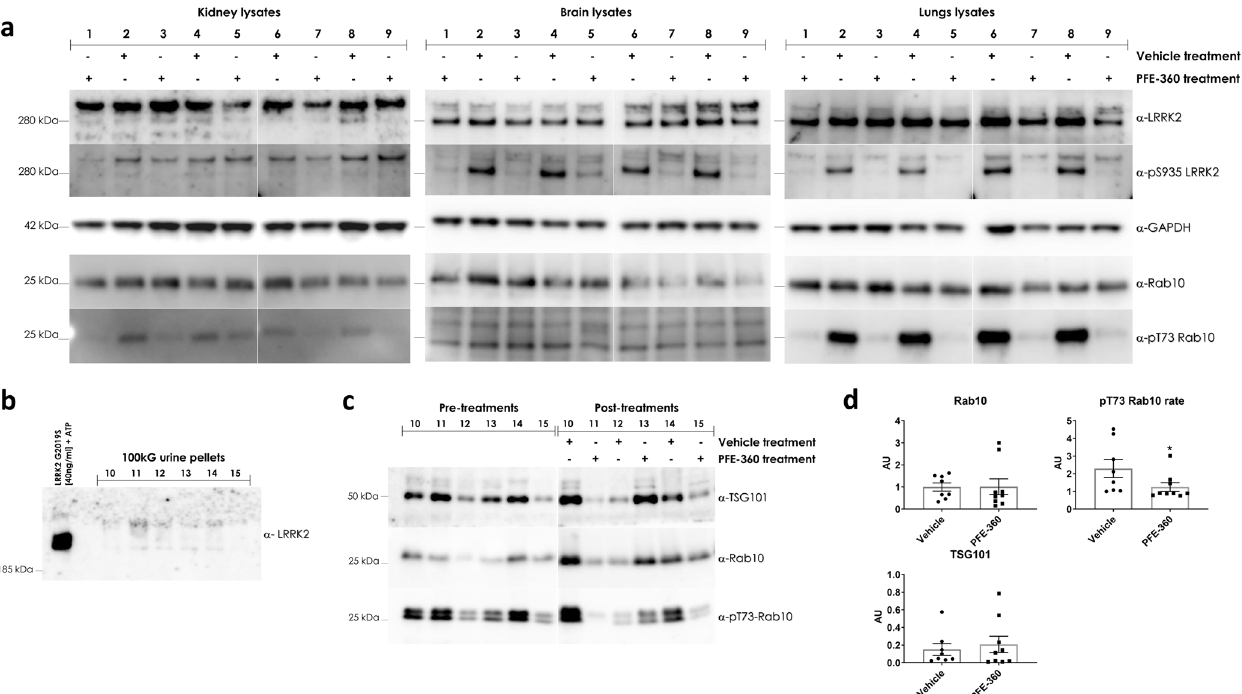
Fig. 5 Detection of LRRK2 & Rab10 in rat organ lysates and in urinary EVs after solvent and LRRK2 kinase inhibitor treatment. a Western blot detection of total LRRK2, pS935-LRRK2, total Rab10, pT73-Rab10 and TSG101 in kidney, brain and lung lysates of rats treated with PF360 or solvent (7.5 mg/kg, 6 h). Note that the blots in kidney yield a non-speci fi c band at a higher molecular weight. b Detection of total LRRK2 in normal rat uEVs, showing very low LRRK2 levels. c Western blot detection of total total Rab10, pT73-Rab10 and TSG101 in rat uEVs, both pre- treatment and after administration of PF360 or solvent (7.5 mg/kg, 6 h) (triplicate measures per sample). d quanti fi cation of ( c ). The values of phosphorylation ‘ rate ’ are indicative of the proportion of protein that is phosphorylated at the given site, see materials and methods. Statistical differences were tested using a two-tailed Mann – Whitney test. Error bars represent standard error of the mean (s.e.m.). * P < 0.05 ( N = 8 –